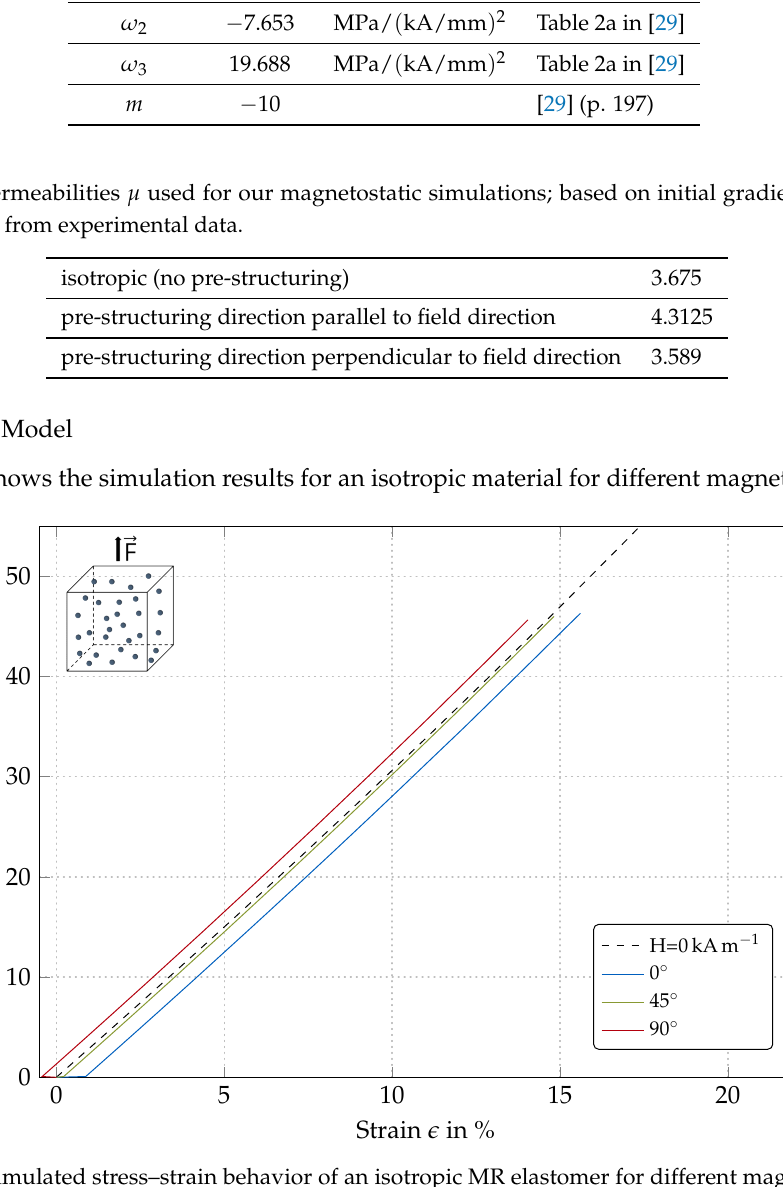
Figure 4. Simulated stress–strain behavior of an isotropic MR elastomer for different magnetic field orientations (H = 30kAm − 1